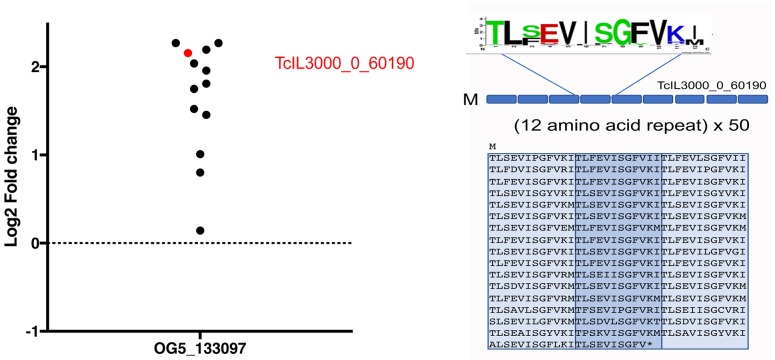
Regulatory profile of Orthogroup OG5_133097 in T. congolense.Members of orthogroup OG5_133097 encompass predicted proteins comprised of 12 amino acid repeats. Many members of this T. congolense enriched orthogroup are upregulated at peak parasitaemia, with TcIL3000_0_60190 being 4.5 fold up regulated at peak parasitaemia (adj p = 0.033). This predicted protein comprises 50 copies of an imperfect 12 amino acid repeat.